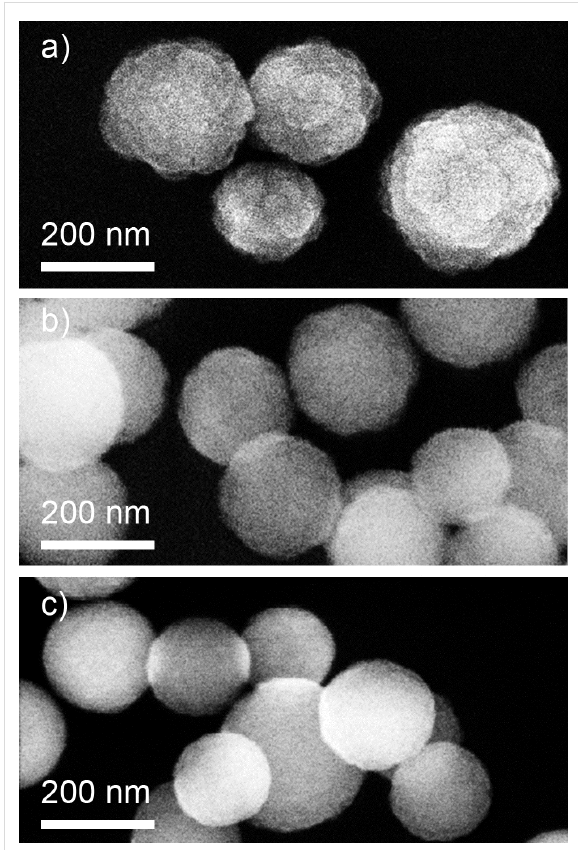
Figure 7: SEM images of NPs prepared by plasma polymerization of HMDSO mixed with Ar: a) without adding oxygen; b) with addition of oxygen at O 2 /HMDSO 1:1 ; c) with addition of oxygen at O 2 /HMDSO 5:1 (obtained in a similar manner as [53]). Total pressure is 55 Pa, dis- charge power is 30 W, HMDSO flow is 0.2 sccm, Ar flow is 2